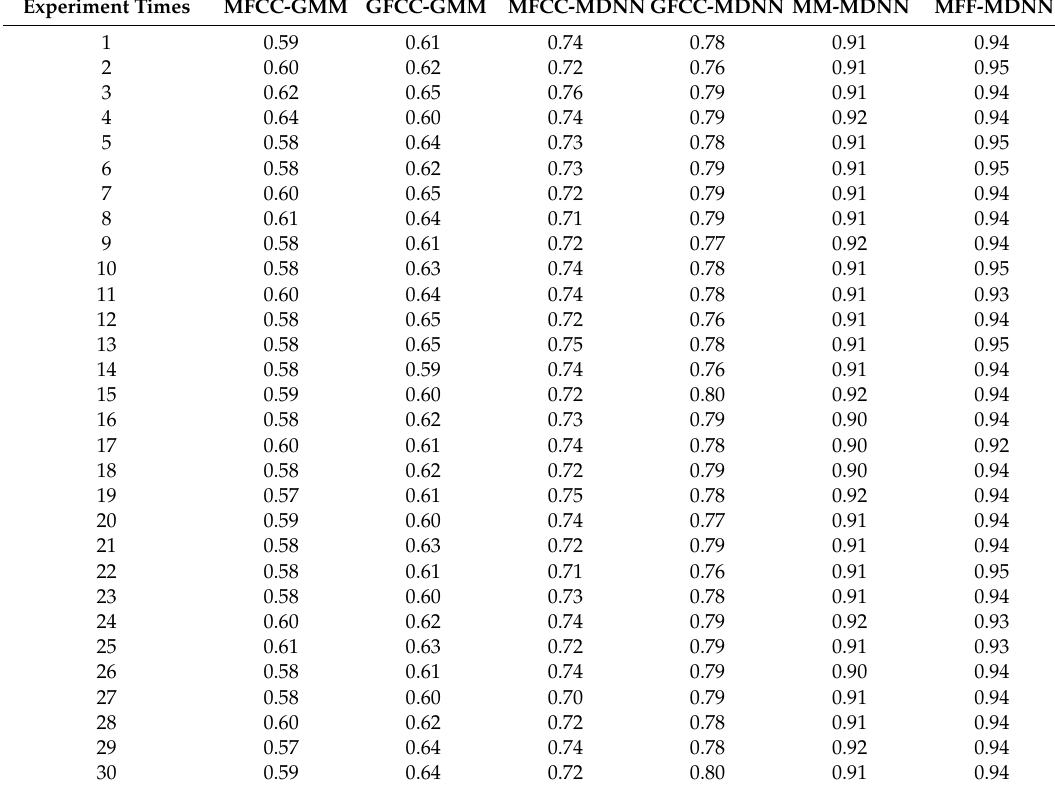
Table 2. The recognition results of 30 experiments with a di ff erent training set and testing set in the